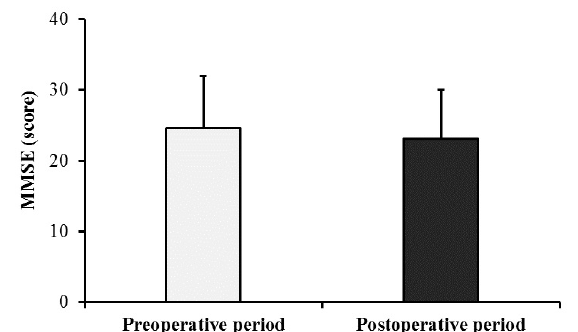
Figure 1 - Patients’ pre- and postoperative Mini-Mental State Exam (MMSE) scores.